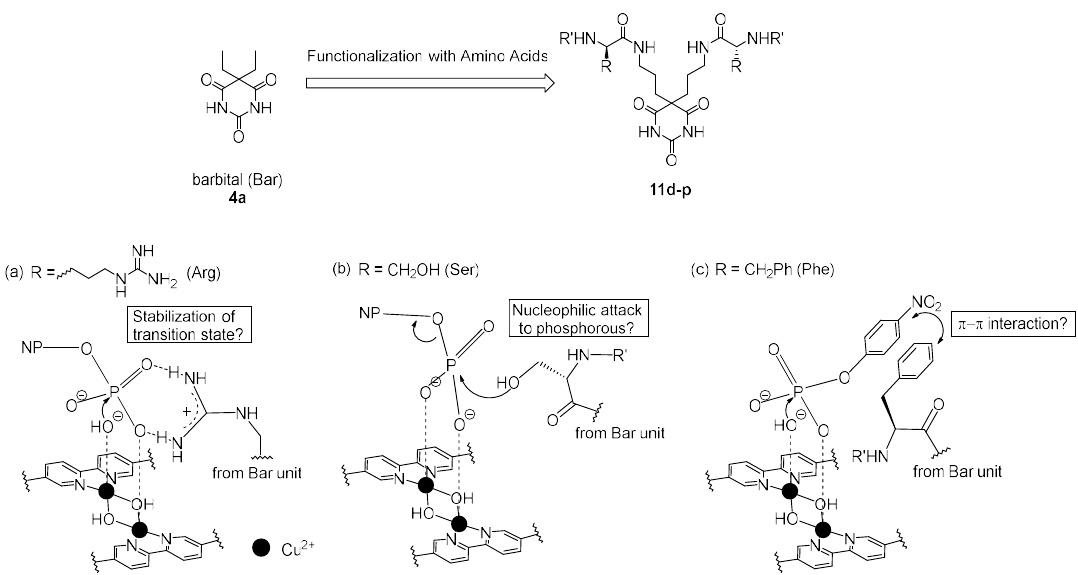
Scheme 3. Predicted effect of new barbital derivatives functionalized with amino acids on